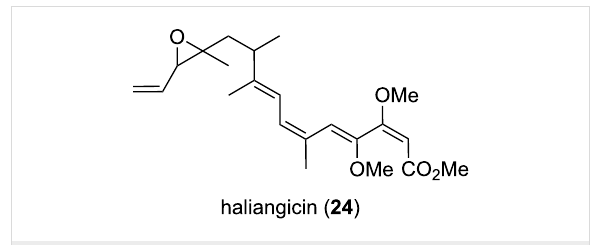
Figure 10: Structure of haliangicin from H.